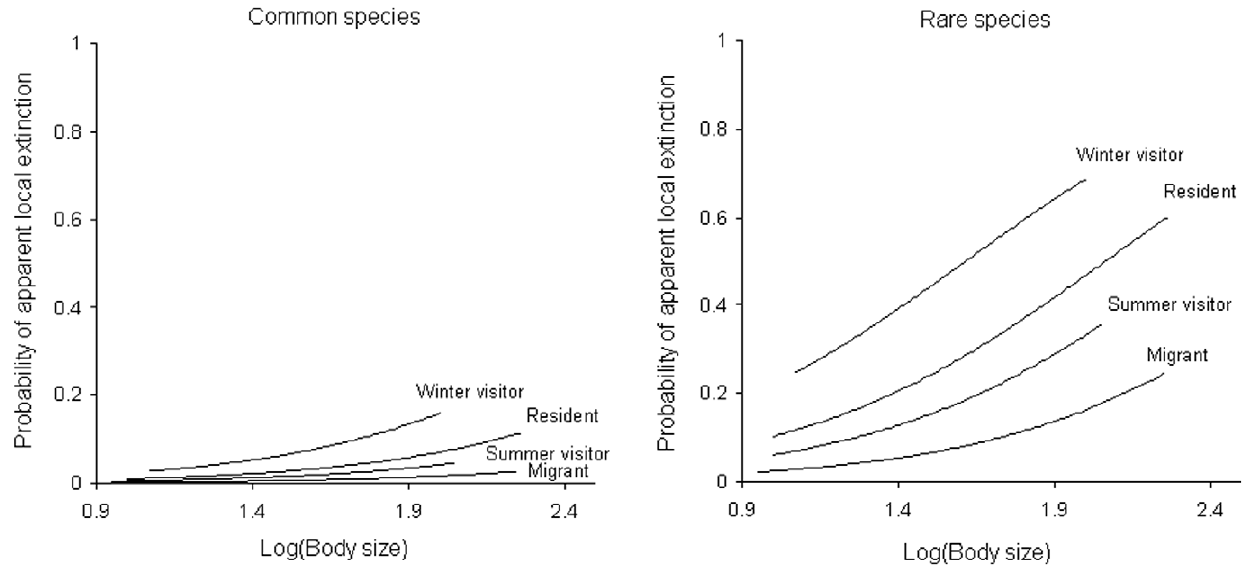
Figure 2. Relationship between the log-transformed body size and the probability of apparent local extinction. The relationship is explained for each category of abundance, for ‘common’ and ‘rare’ bird species recorded in the study area (see Table 3 for statistical details).